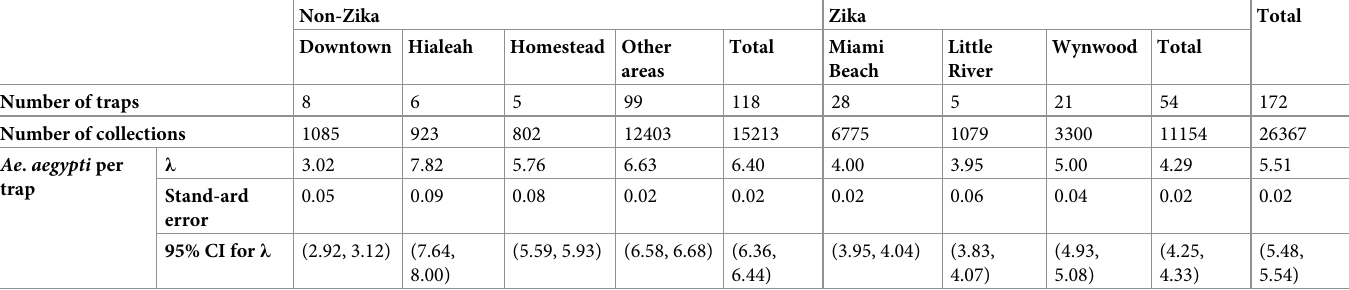
Table 2. Summary statistics for Ae . aegypti collected at areas across Miami-Dade County. Data are grouped into locations affected by local Zika virus transmission during the 2016 outbreak and unaffected. Areas are further subdivided into six defined regions. Trap counts from each region were fitted to a Poisson distribution. Appro- priate statistics and 95% confidence intervals for λ are shown.